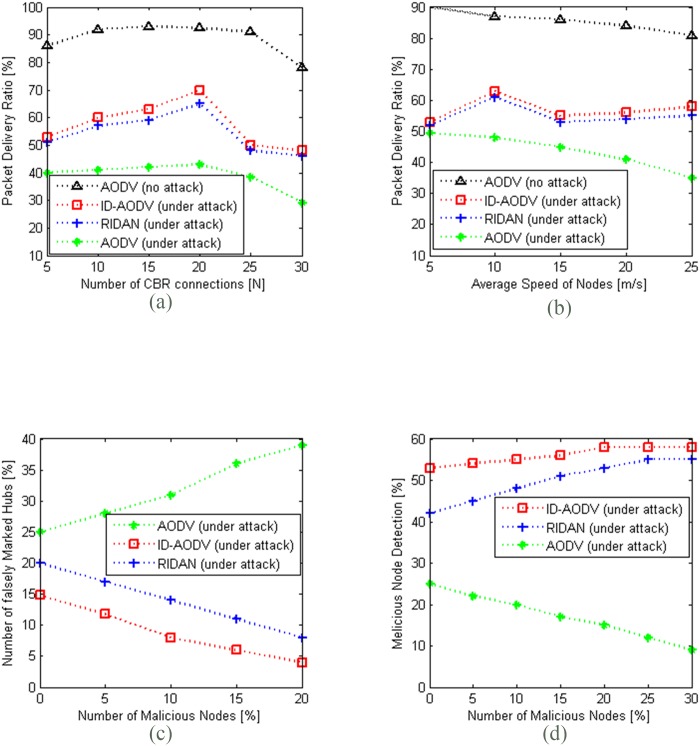
Under sequence number attack: (a) Impact of number of CBR connections on packet delivery ratio, (b) Impact of average speed of nodes on packet delivery ratio, (c) Impact of percentage of malicious nodes on number of falsely marked hubs, (d) Impact of percentage of malicious nodes on percentage of malicious node detection.